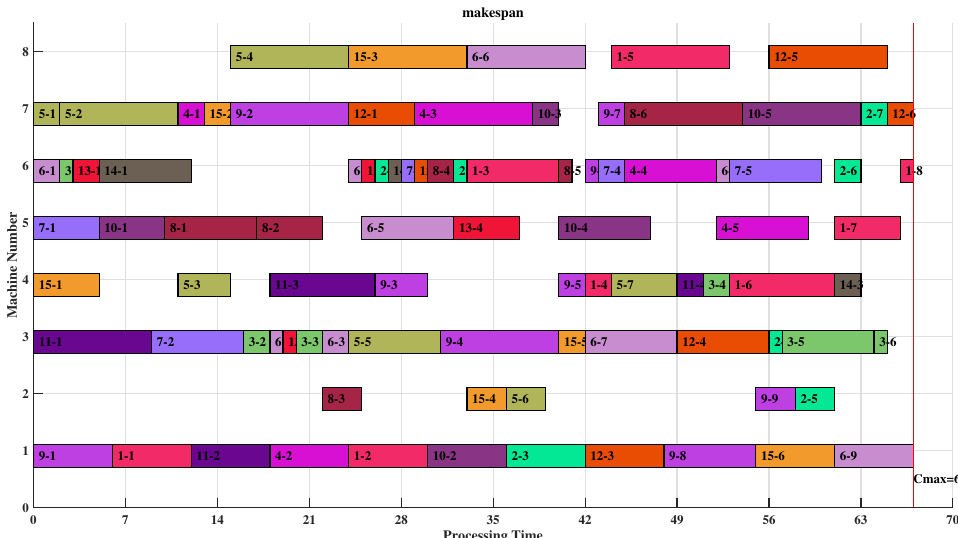
Figure 16. The scheduling scheme of Brandimarte MK4 (15 ×